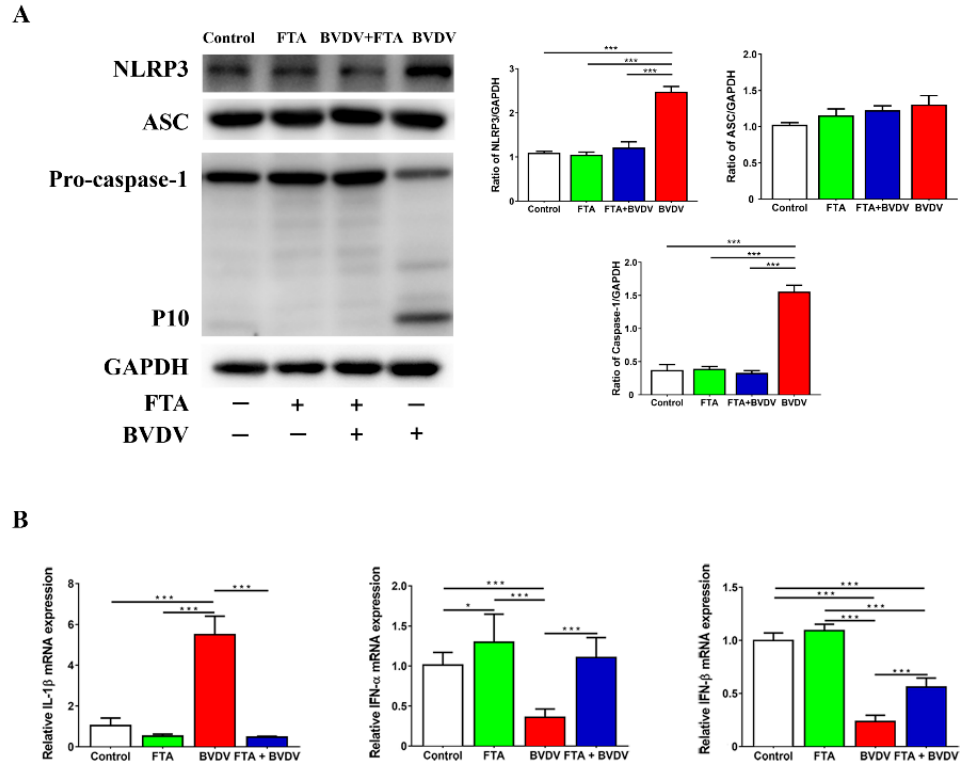
Figure 3. FTA treatment reduced BVDV-induced activation of the NLRP3 inflammasome and in- creased the IFN-I mRNA. ( A ) Immunoblot analysis of NLRP3, ASC, and Caspase-1 protein expression in cells. ( B ) IFN- α and IFN- β mRNA levels in cells were detected by RT-qPCR. Data from three independent experiments and error bars are presented as the mean ± SEM. * p < 0.05, *** p < 0.001.